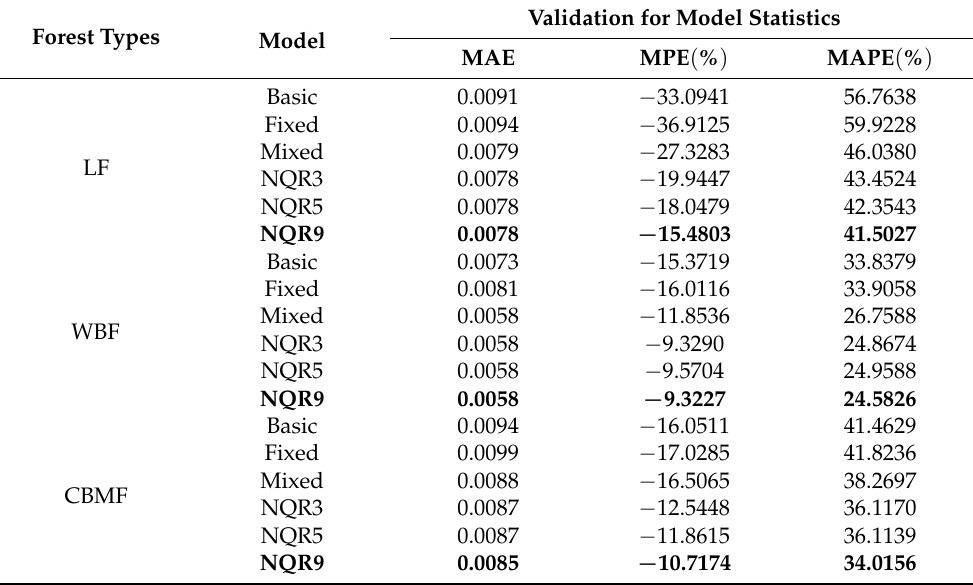
Table 4. Model validation statistics of the six different methods for LF, WBF, and CBMF.